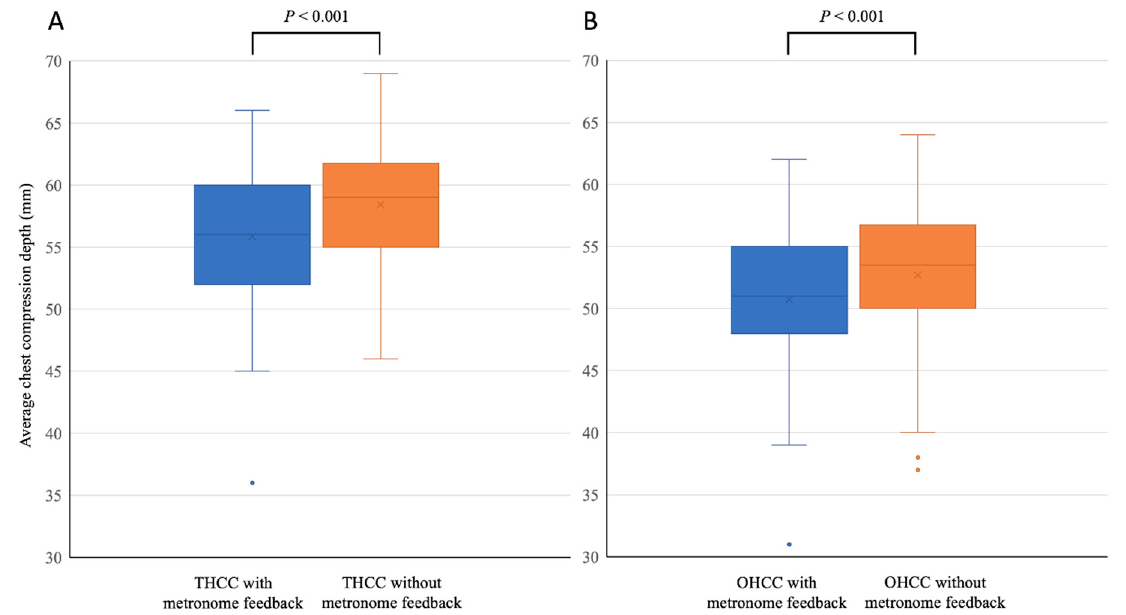
Figure 3. Comparisons of average chest compression depth during cardiopulmonary resuscitation performed with and without audio feedback provided using a metronome. ( A ) Pediatric cardiopulmonary resuscitation performed using the two-handed chest-compression (THCC) technique; ( B ) pediatric cardiopulmonary resuscitation performed using the one-handed chest-compression (OHCC) technique.